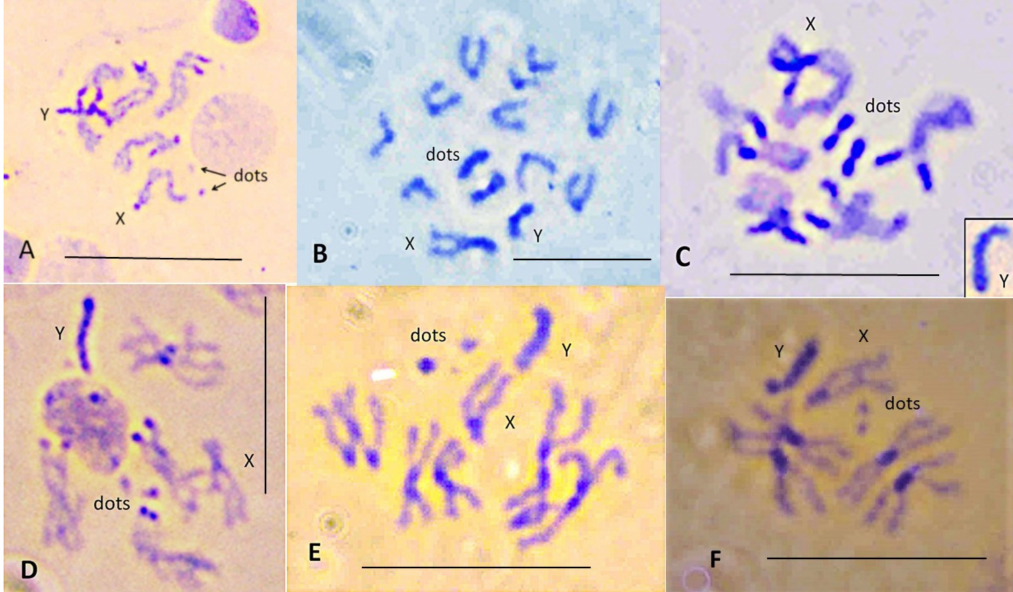
Figure 4. C-banding of cerebral ganglia chromosomes. ( A ) Scaptodrosophila claytoni male. X shows 2 internal C-bands. Y and ‘dots’ are also indicated. ( B ) Scaptodrosophila sp. aff. cancellata male, where X, Y and ‘dots’ are indicated. ( C ) Scaptodrosophila cancellata female, where X and ‘dots’ are indicated; Y is shown as an insert. ( D ) Scaptodrosophila sp. aff. concolor strain CBN17 male, note the pale C-band on X. ( E ) Scaptodrosophila xanthorrhoea male. ( F ) S. sp. aff. novoguineensis male. Bar = 5 µ